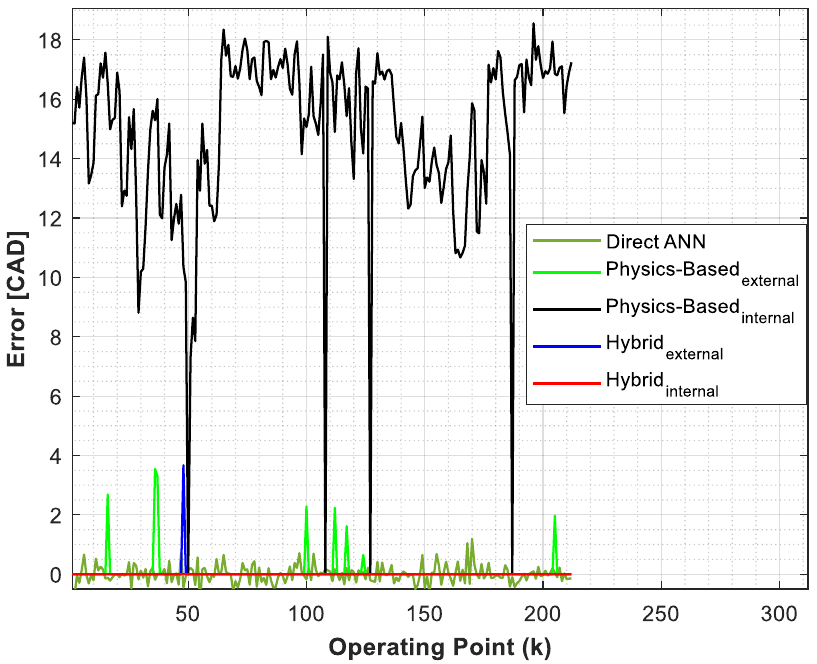
Figure 21. Comparison of CA50 model errors in a stochastic environment.